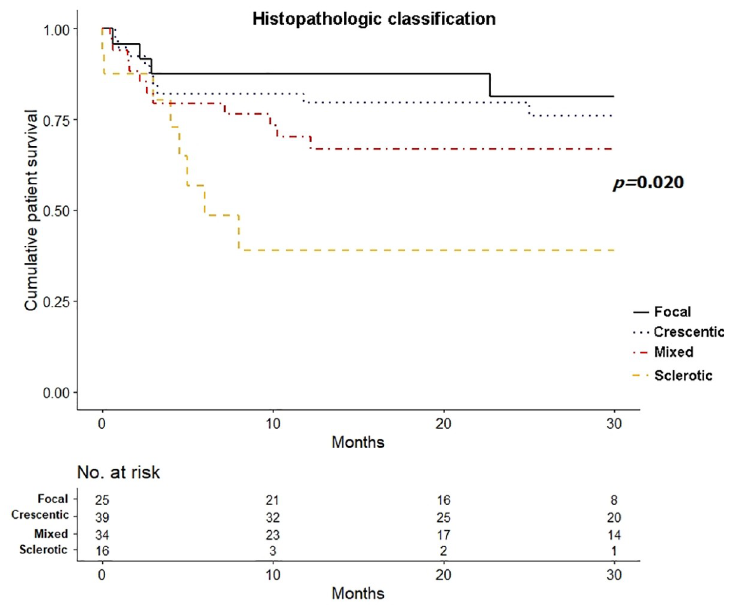
Fig 4. Comparison of patient survival by histopathologic classification.